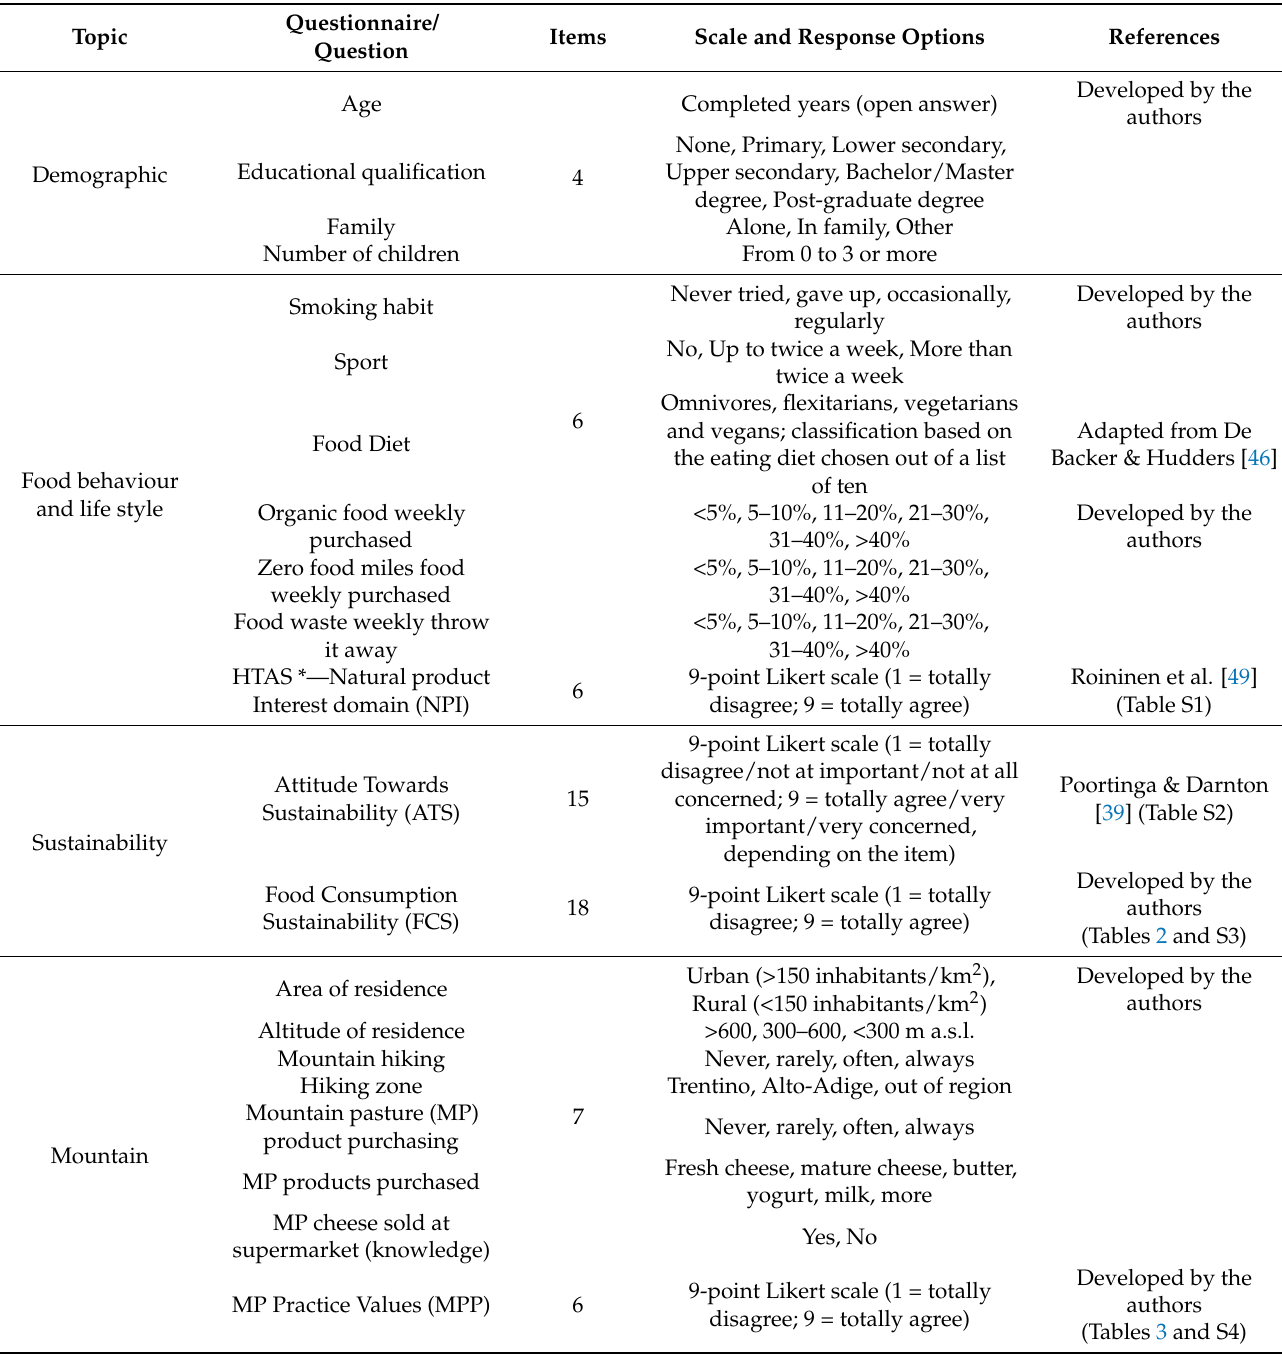
Table 1. Demographics, food behaviour questions, attitude questionnaires, and their relative acronyms, number of items, rating scale, response options, and